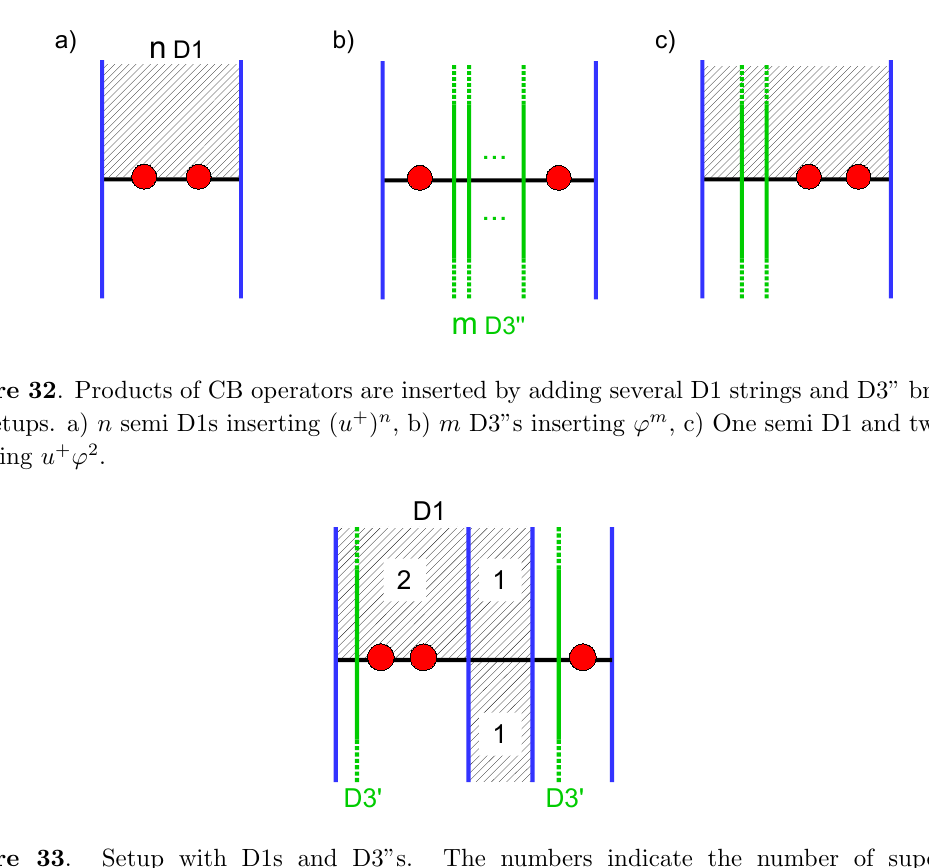
Figure 33 . Setup with D1s and D3"s. The numbers indicate the number of superposed D1s in each